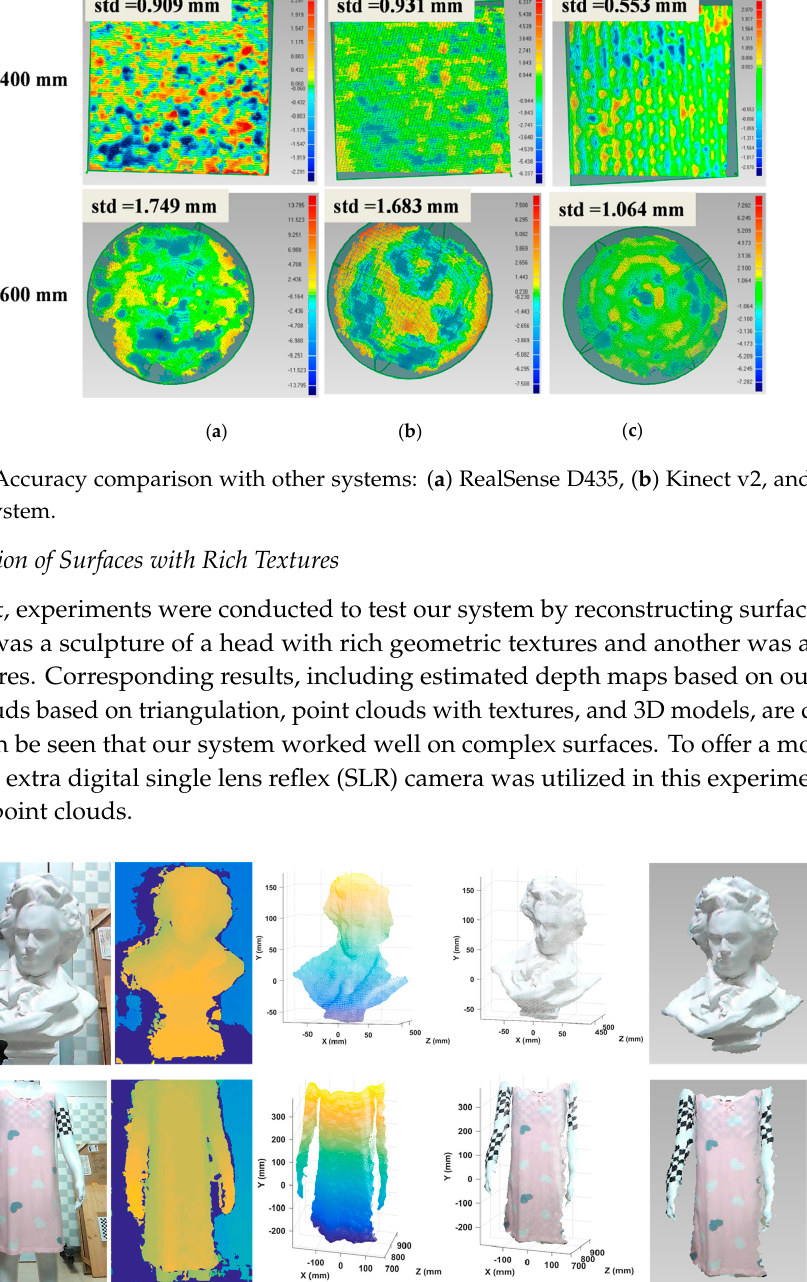
Figure 15. Reconstruction results of surfaces with rich textures using the proposed system. From left to right: original images, estimated depth maps, reconstructed point clouds, point clouds with textures, and 3D models.